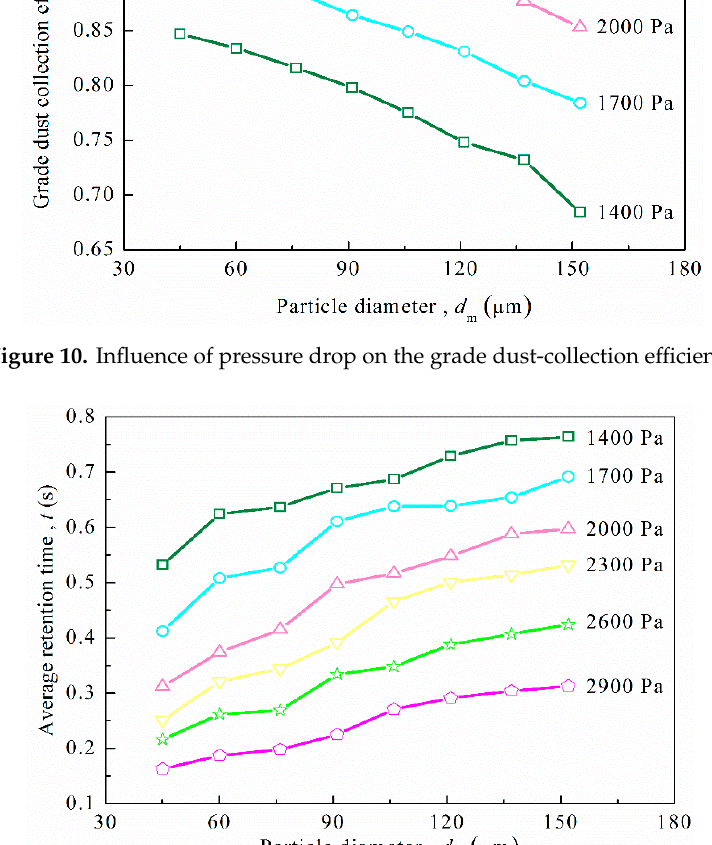
Figure 12. Influence of traveling speed on the separation efficiency.